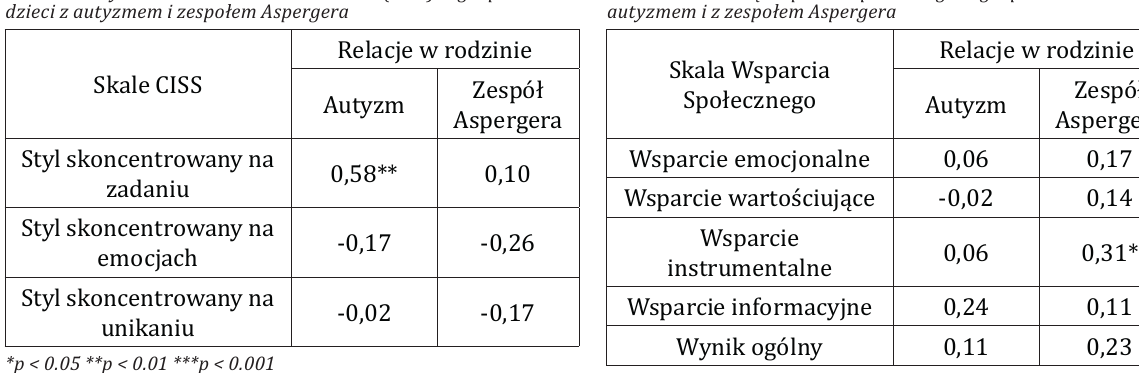
statycznie zależność między pozytywną oceną relacji w rodzinie przez badane, a preferowaniem przez nie w sytuacji stresu stylu zorientowanego na zadaniu. 5.